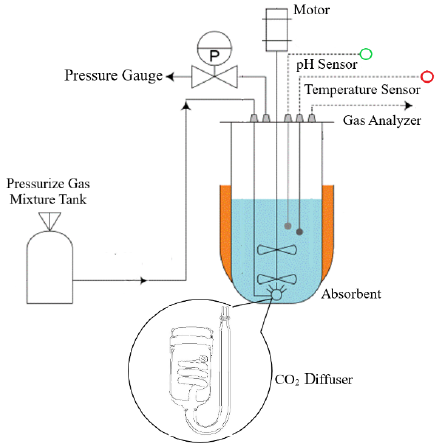
Figure 1. Carbon dioxide absorption system.